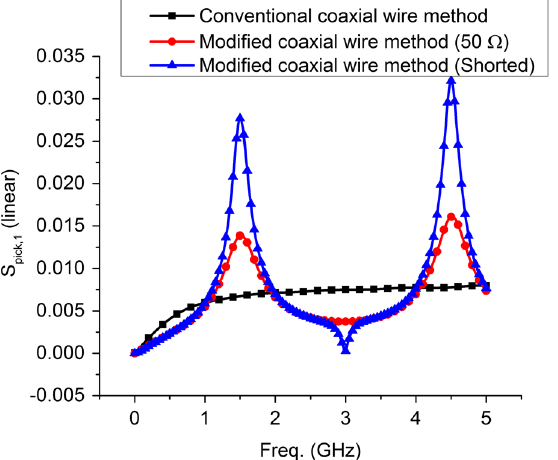
FIG. 8. S-parameters obtained through simulation of conven- tional and modified coaxial wire methods for the calculation of transfer impedance of the test